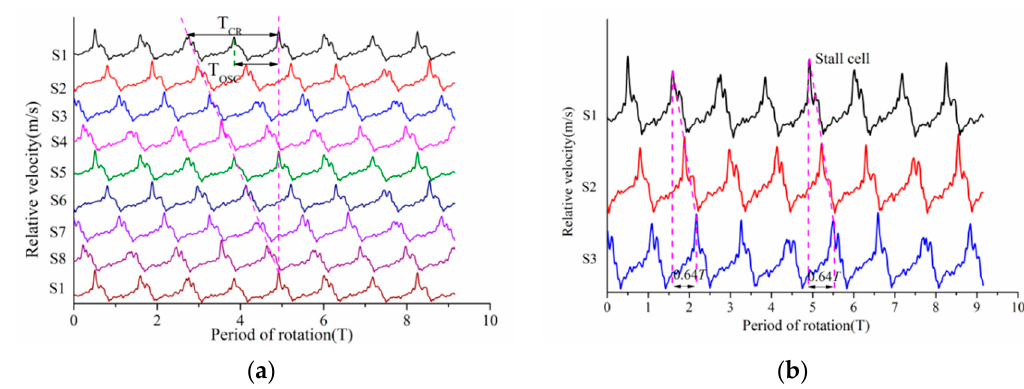
Figure 16. Relative velocity curve of the monitoring point when the flowrate is 0.7 kg/s: ( a ) rhe curve of the relative velocity at 8 points; ( b ) the curve of the relative velocity at 3 adjacent points. When the flow rate is reduced to 0.6 kg/s, the relative speed curve of the monitoring point in the that T CR /T OSC = 2, and the number of stable stall cells is 2.